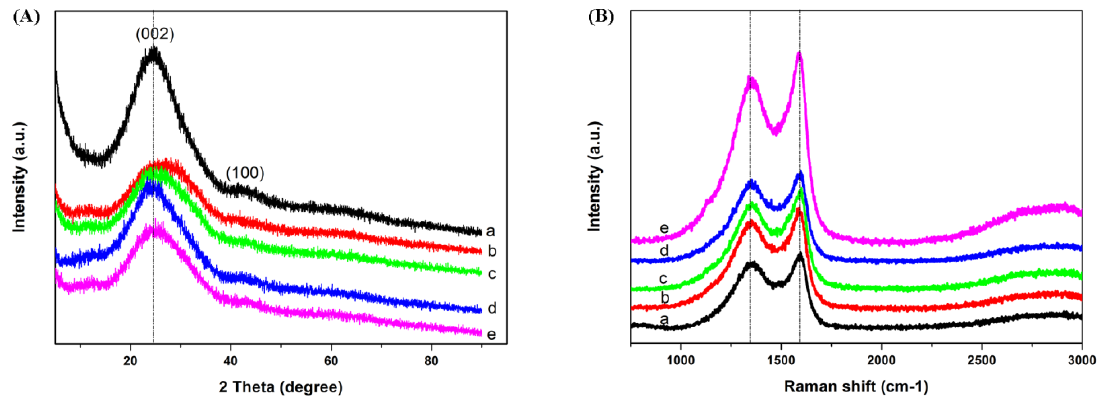
Figure 2. SEM mapping results of ACF-10.3% PDPP.